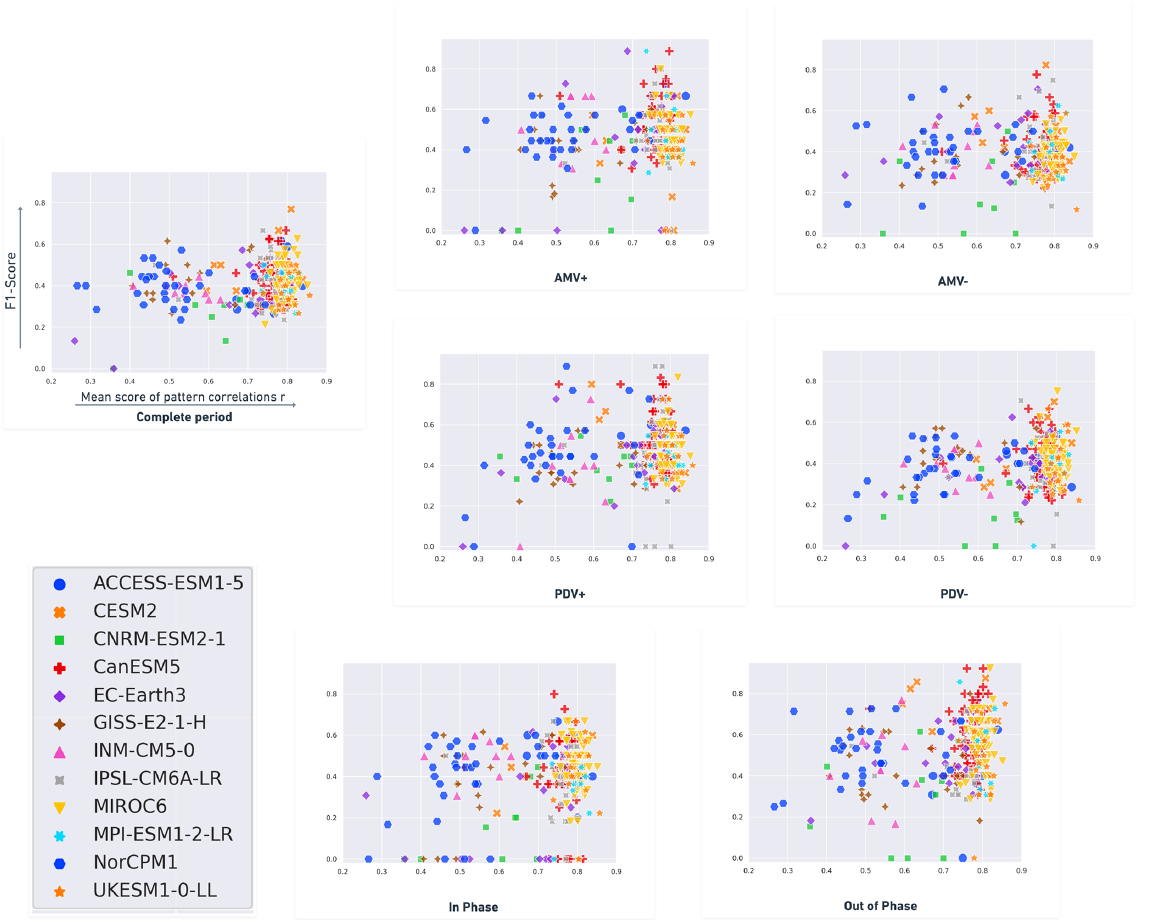
Figure 10. Scatter plots: R coef mean score (spatial correlation with reanalysis – x axis) vs. F 1 score (network similarity with respect to reanalysis – y -axis) during the different regimes. Spatial correlation values do not change from one regime to another; these are the same mean scores calculated from the Pearson r coefficients of the four modes in Sect. 3.1 over the 1900–2014 period. Similarly to Fig. 9, scatter plots are shown only for the long